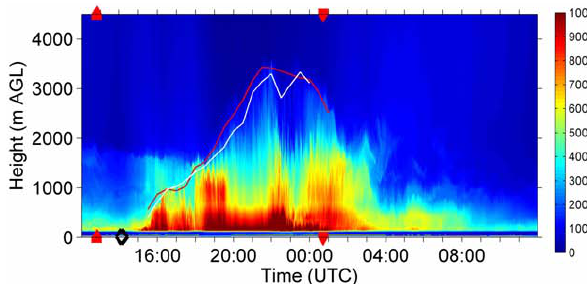
Fig. 5. Backscatter signal strength as a function height on 9 March 2006 for the lidar deployed at the T1 site. The white line denotes the subjectively determined estimate of mixed layer depth from the lidar, while the red line is the same quantity derived from the radar wind profiler. Red triangles denote sunrise and sunset (Source: Shaw et al.,